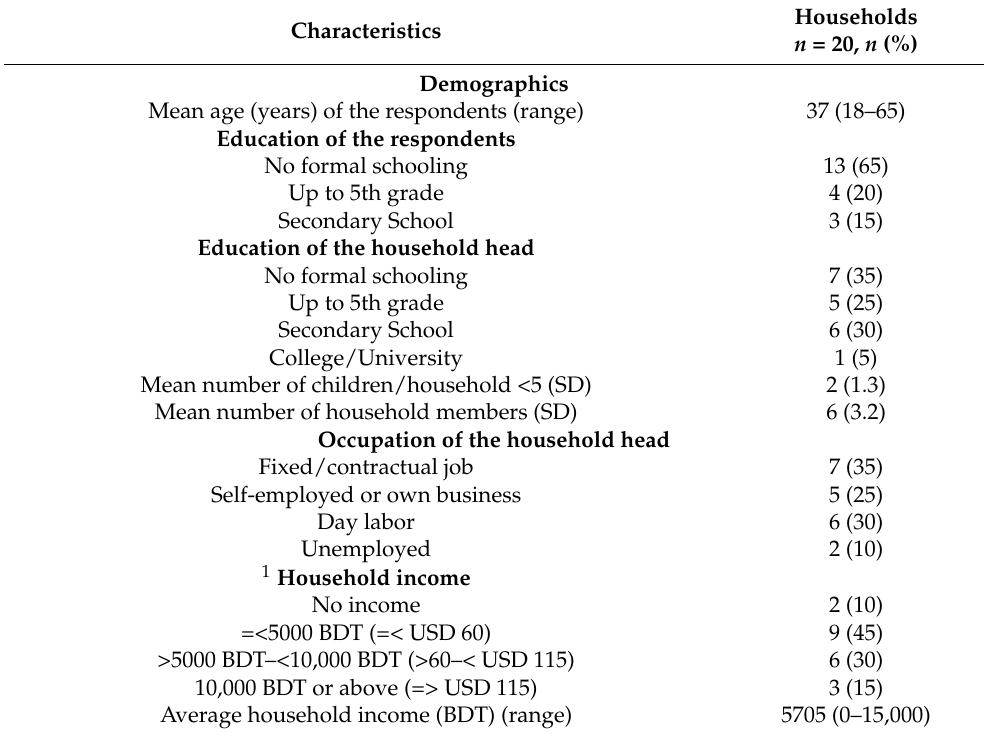
Table 1. Demographic characteristics, water collection, storage practice, and drinking water satisfac- tion level at baseline in FDMN camp, Cox’s Bazar,